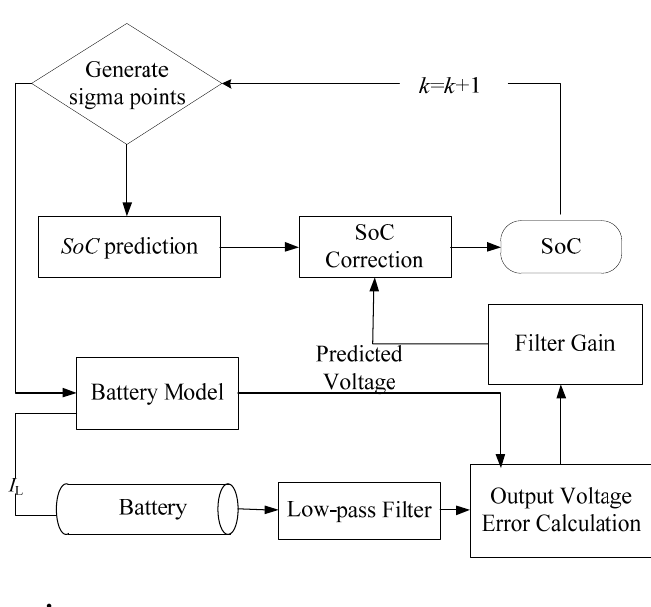
Figure 9. SoC estimation based on